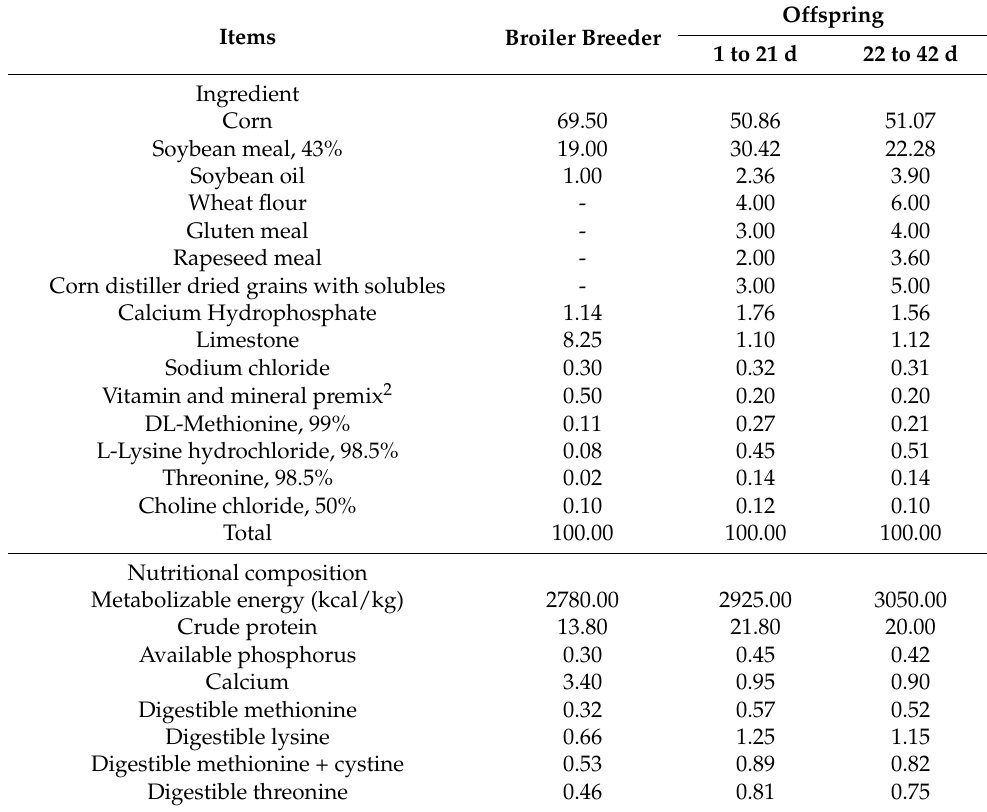
Table 1. The composition and nutrient levels of the basal diet (%, as fed-basis) 1